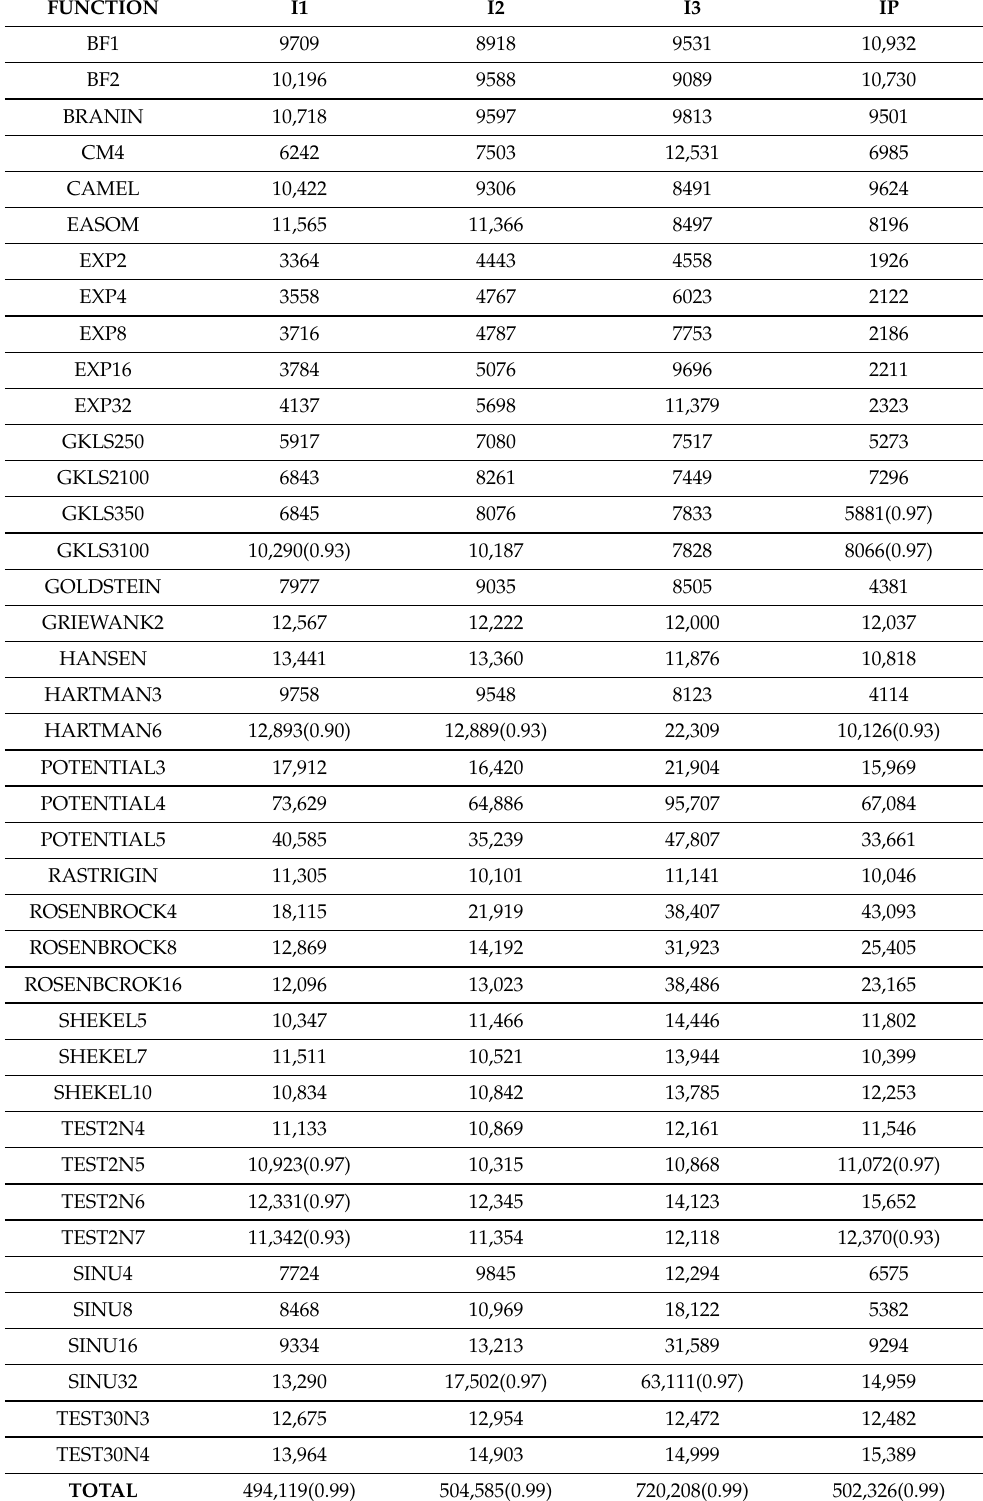
Table 3. Experiments with the Ali stopping rule with the gradient check